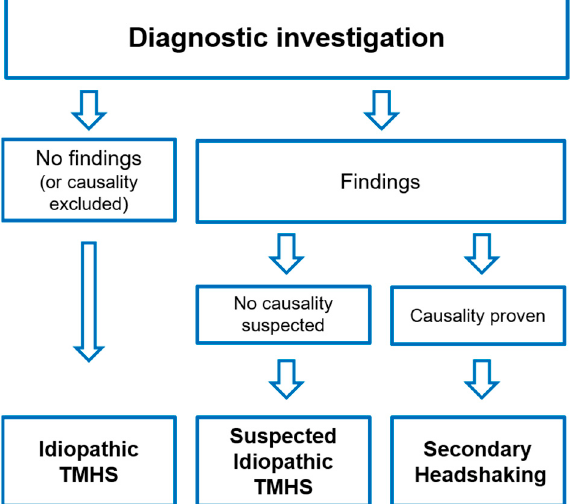
Figure 1. Flowchart of the diagnostic investigation of horses with headshaking in the current study. TMHS: trigeminal-mediated headshaking.